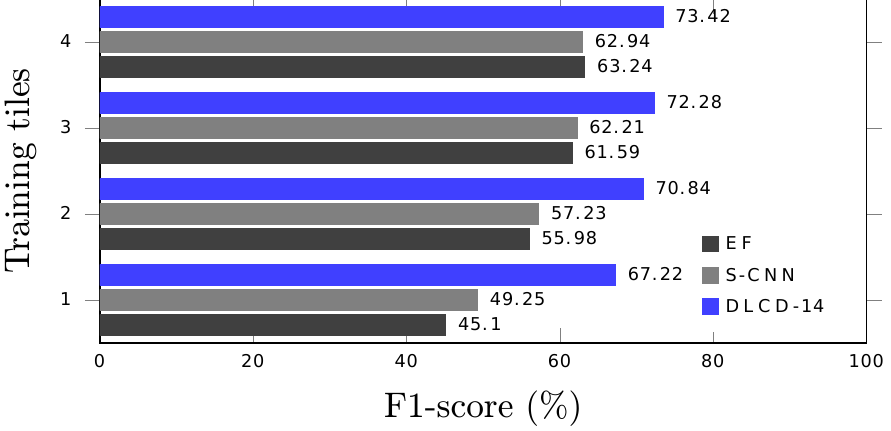
Figure 5. F1-Scores for distinct volumes of training